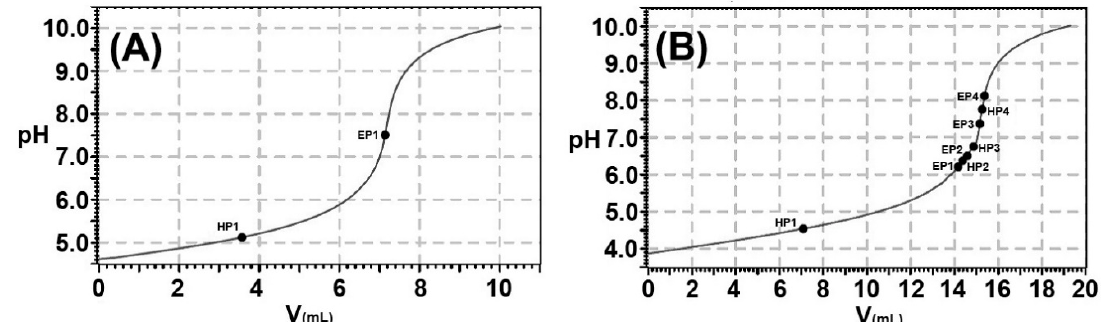
Figure 2. Automatically generated titration curves for the estimation of pKa values (CALB-catalyzed hydrolysis). Curve ( A ) corresponds to the titration of erythritol tetraoleate (one pKa = 5.12), while curve ( B ) corresponds to the titration of pentaerythritol tetrastearate (four pKa = {4.54, 6.38, 6.76, and 7.76}).